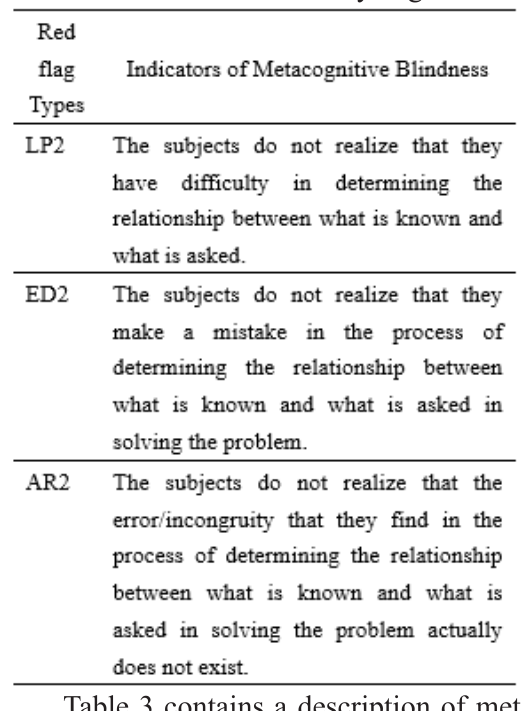
Table 2. Indicators of Metacognitive Blindness at the Phase of Analyzing Problems